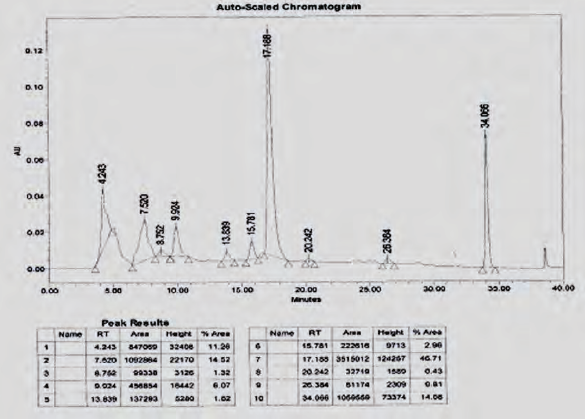
Figure-5. HPLC OF Aq.Ex of A. graveolens